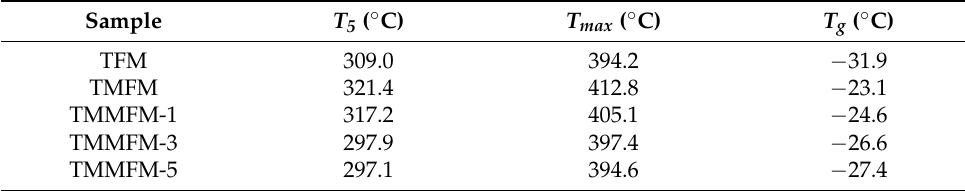
Figure 3. TGA ( a ) and DSC ( b ) curves of TFM, TMFM and TMMFM. Table 2. Thermal characteristics of TFM, TMFM and